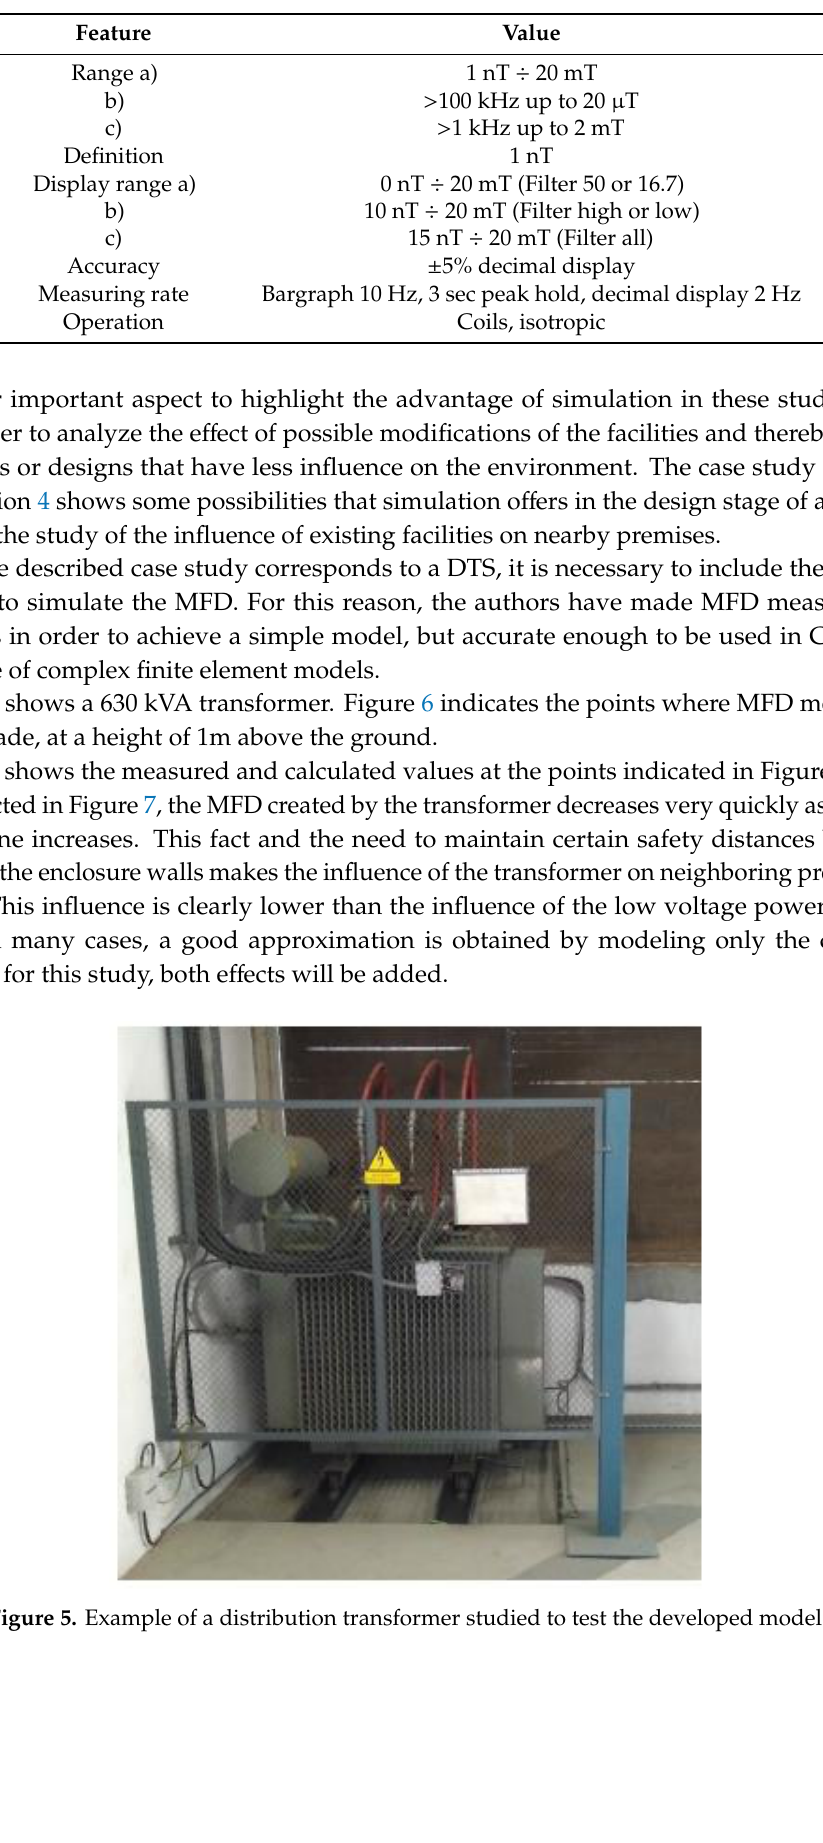
Table 2. Three-dimensional H / E fieldmeter ESM-100 Maschek technical data.